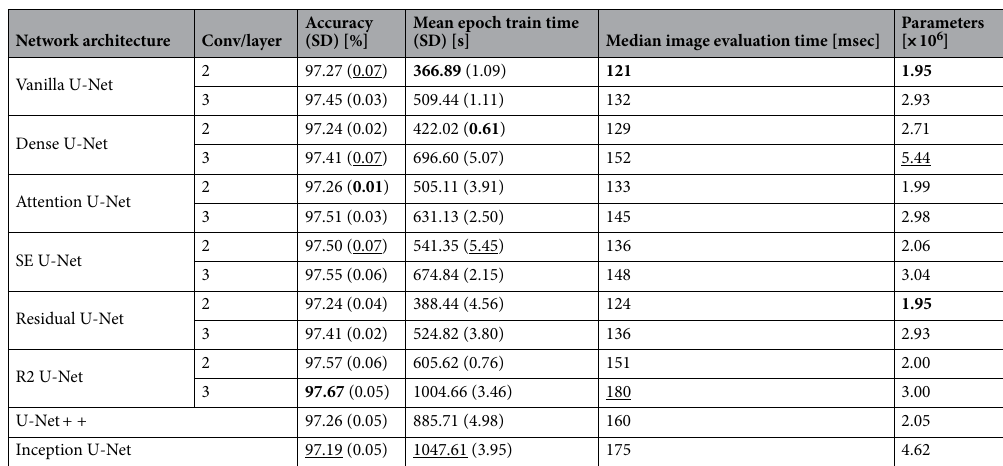
Table 3. Comparison of results for the Stargardt disease dataset. (SD: standard deviation, s: seconds, SE: squeeze + excite, R2: recurrent-residual). The best and poorest results for each are annotated in bold and underline text